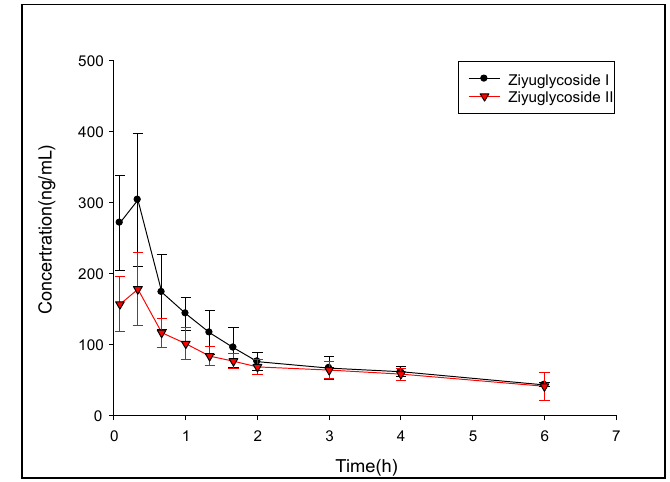
Figure 4. Mean plasma concentration-time profiles of ZGS1 and ZGS2 after tail vein administration of ZGS1 (10 mg/kg) ( n = 5).